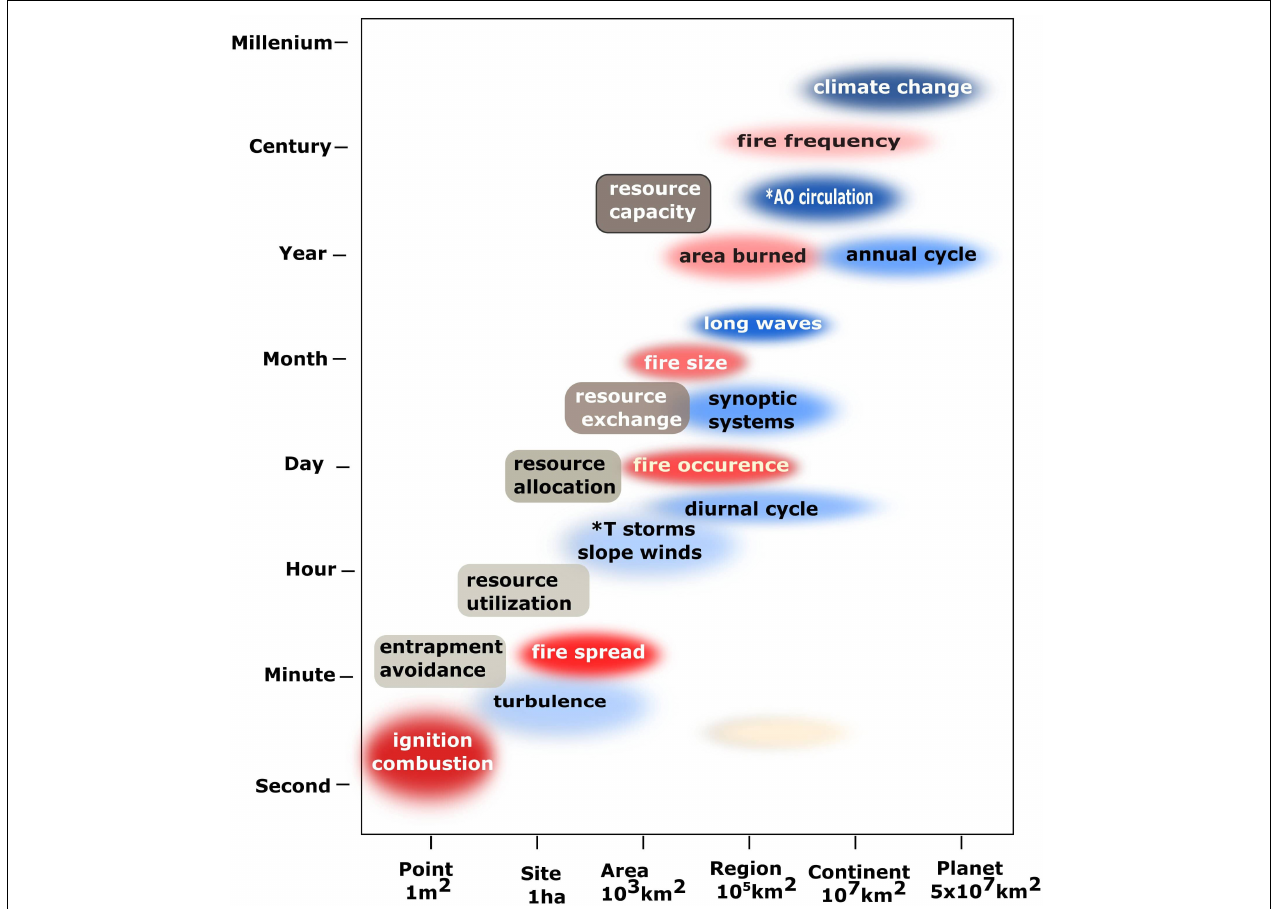
FIGURE 8 | The atmospheric energy cascade (blue ovals) shapes an inverse cascade of fire processes (red ovals) and the fire management supply chain (gray rectangles). Adapted from Simard (1991); Holling (2001), Taylor et al. (2013). *AO = Atmospheric Oceanic, T-storm = thunderstorm.